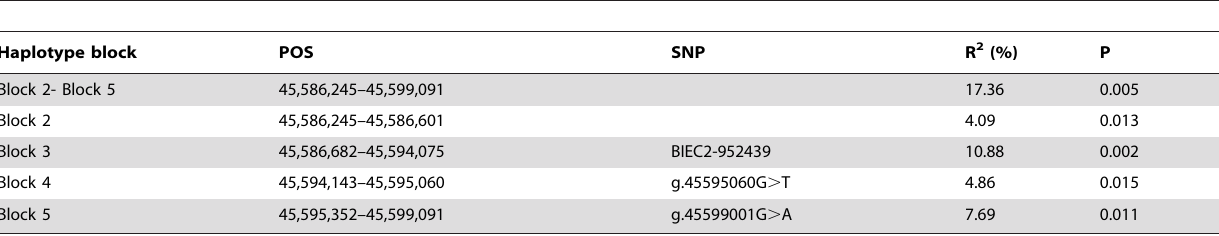
Table 3. Haplotype blocks within PLCz1 significantly associated with estimated breeding values for the paternal component of the pregnancy rate per estrus cycle (EBV-PAT) in Hanoverian